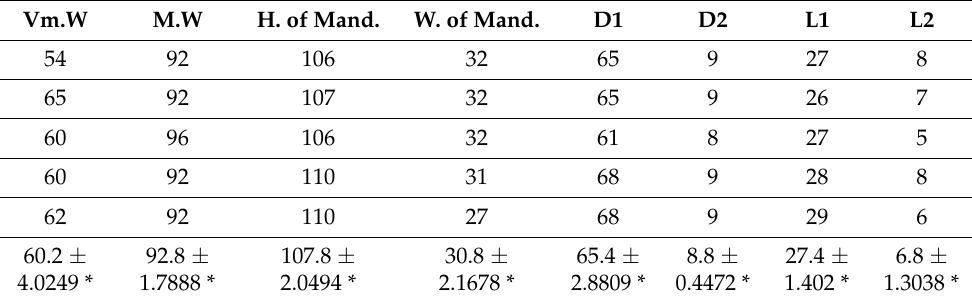
Table 1. Morphology of 5 of the 11 Belgica antarctica fourth-instar larvae collected from Jougla Point. Measurements (in µ m) are presented of: Vm.W—width of ventromentum, including the middle tooth + two teeth on both sides, M.W—width of mentum; H. of mand.—height of the mandible; W. of mand—width of mandible; D1—distance between setae of mentum; D2—distance from base to the RO of the first antennal segment; L1 and L2—length of antennal segments 1 and 2. Vm.W